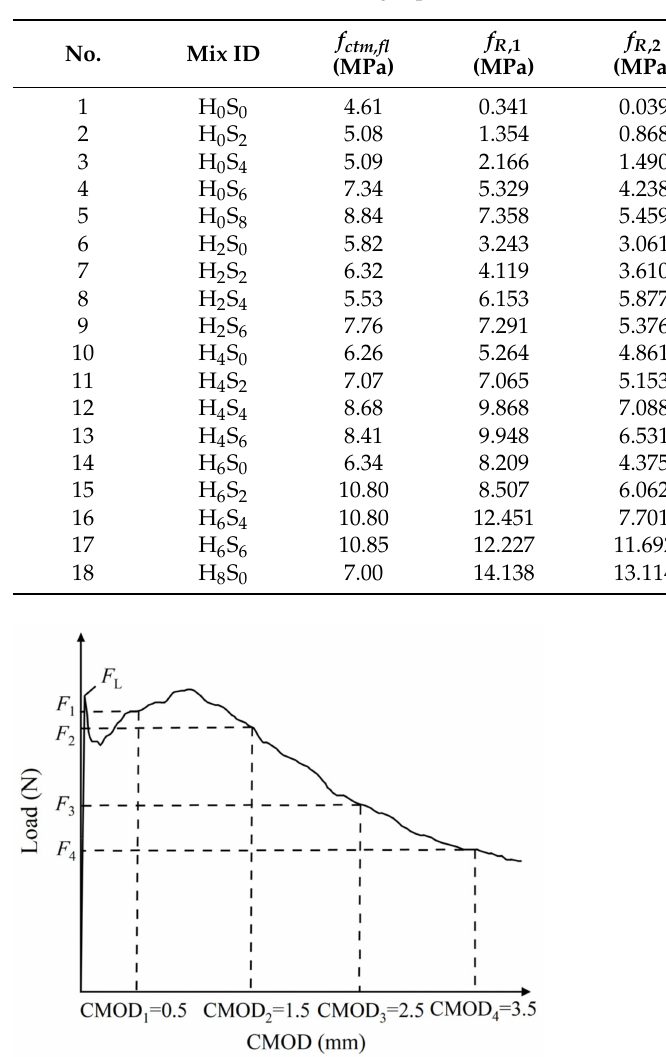
Table 3. Table of CMOD tensile strength parameters.